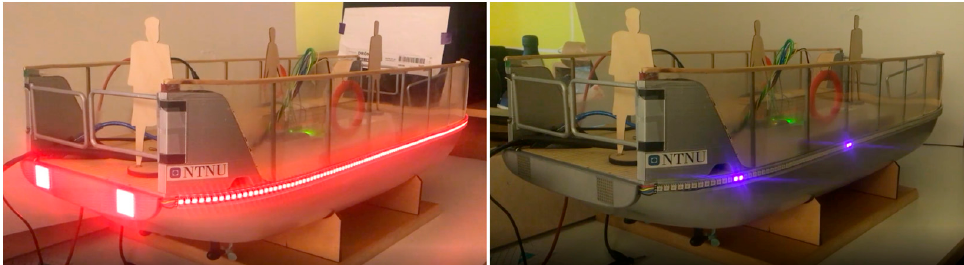
Figure 12. Visual signals used to communicate the milliAmpere2 ′ s state and intention to secondary users, such as other vessels and bystanders (Left: distress signal; right: vessel detection; image credit Jonas Selvikvåg, used with permission).